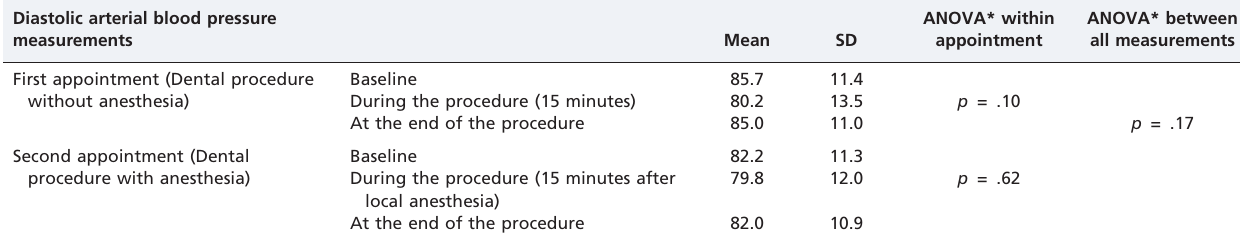
Table 3 - Mean, standard deviation (SD), and results of statistical analyses of six diastolic arterial blood pressure measurements taken during two different appointments for dental treatment with and without LAVA (2% mepivacaine with adrenaline 1100,000) (n= 37).